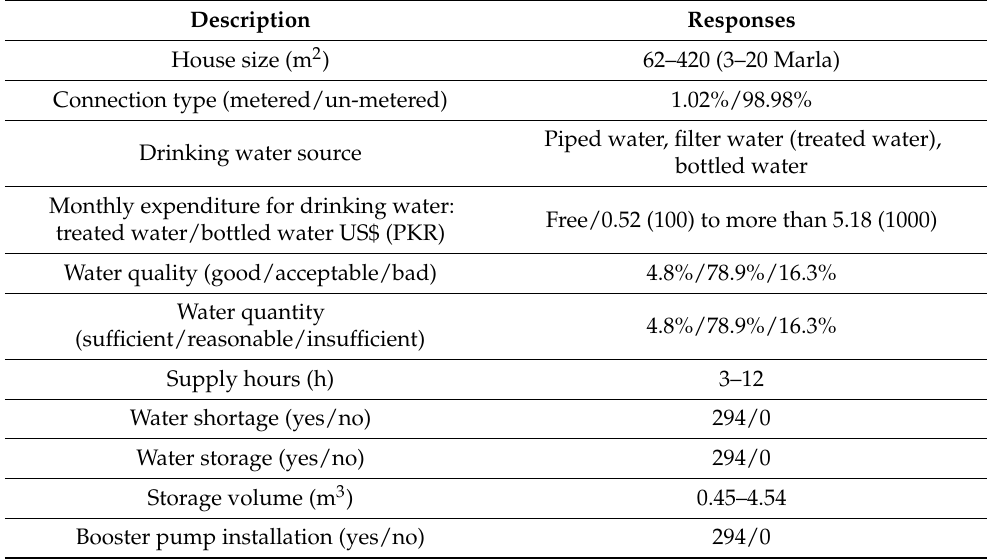
Table 4. Summary of customer survey in August–September 2021 (n =